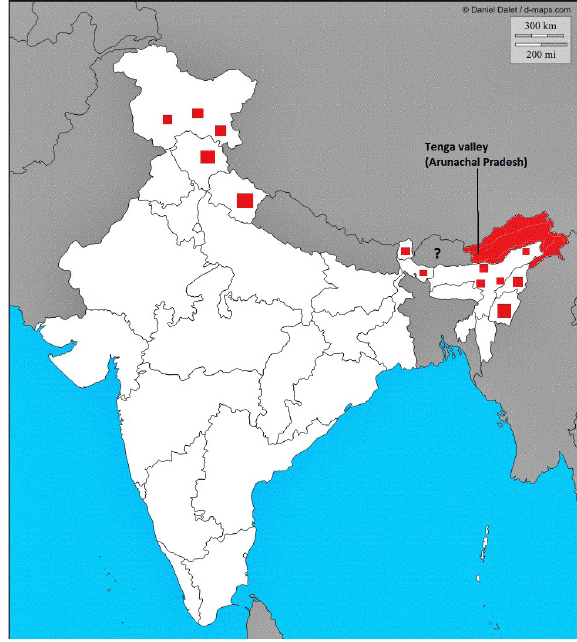
Figure 1. Distribution of subspecies Arhopala rama ramosa in India. Figure 2. Distribution of subspecies Arhopala rama rama in